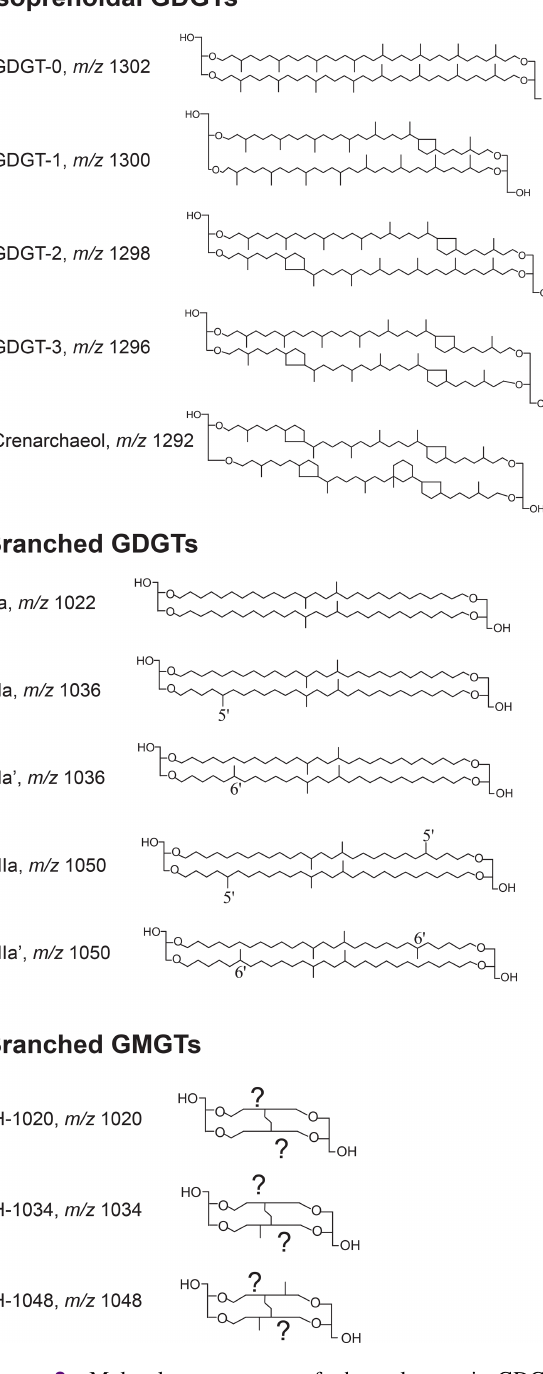
Figure 2. Molecular structures of the relevant isoGDGTs, brGDGTs and brGMGTs as well as their terminology as described in this study. Crenarchaeol isomer (not shown) differs from crenar- chaeol in the stereochemistry of the cyclopentane moiety adjacent to the cyclohexyl moiety (Sinninghe Damsté et al., 2018b). For the terminology of the brGMGTs, for which the exact chemical struc- ture is still unclear, we follow Baxter et al. (2019), since we identify the same isomers (see Fig. S2 for a